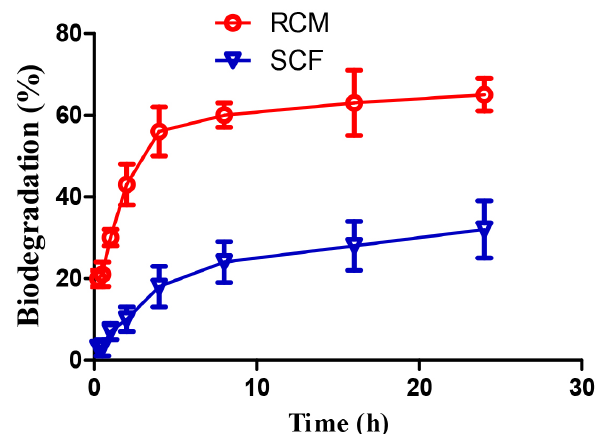
FIGURE 5 - Biodegradation of the optimal film in SCF and